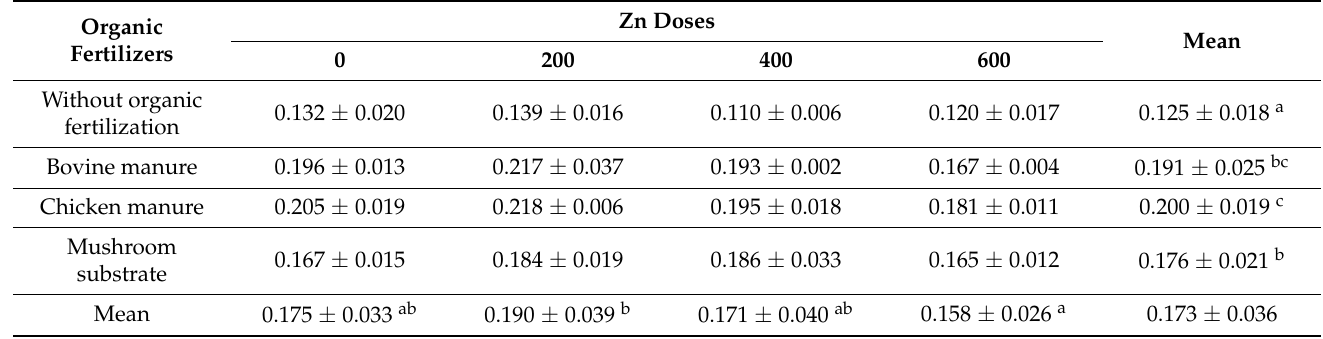
Table 4. Total phosphorus uptake (P g · pot − 1 ) by cocksfoot in three years under different zinc doses (Zn mg · kg − 1 of soil) and organic fertilization (mean ±